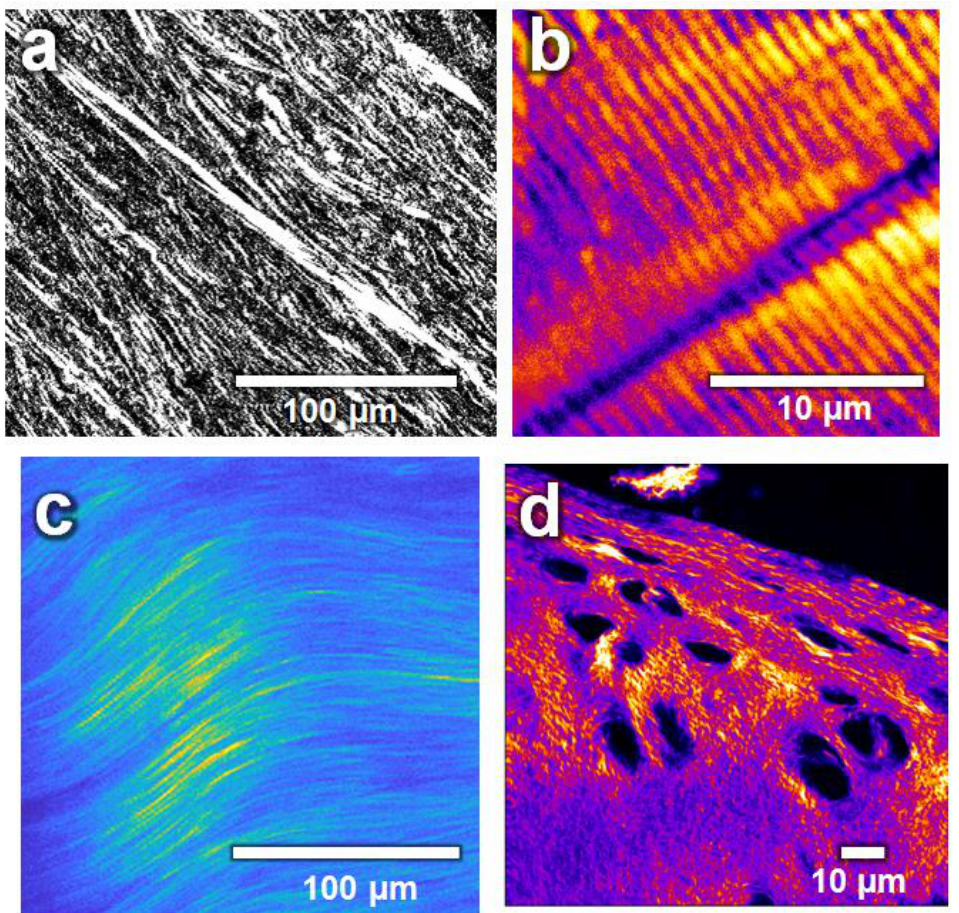
Figure 3. Biological tissues and their collagen fiber orientation imaged by second-harmonic generation microscopy. ( a ) Transverse cut of a human cornea. ( b ) Skeletal muscle from zebrafish (myosin). ( c ) Adult mice-tail tendon. ( d ) Surface cartilage from a knee of a mature horse. Image by BP-Aegirsson CC BY-SA 4.0.